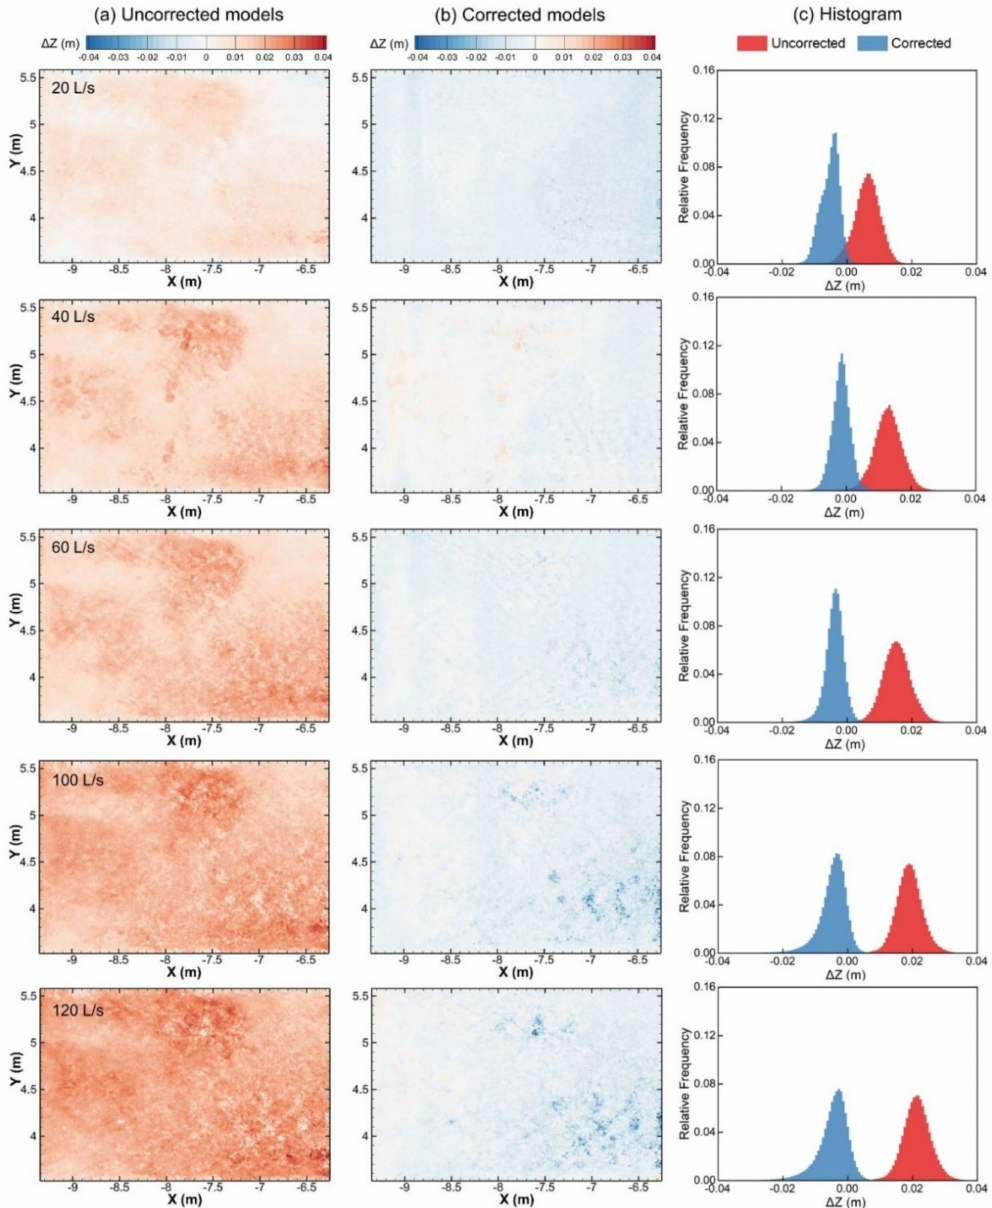
Figure A3. The contours and histograms of elevation errors for the through-water SfM models using all the GCPs for MR2: ( a ) uncorrected models; ( b ) corrected models; ( c ) histograms. Flow goes from the left to the